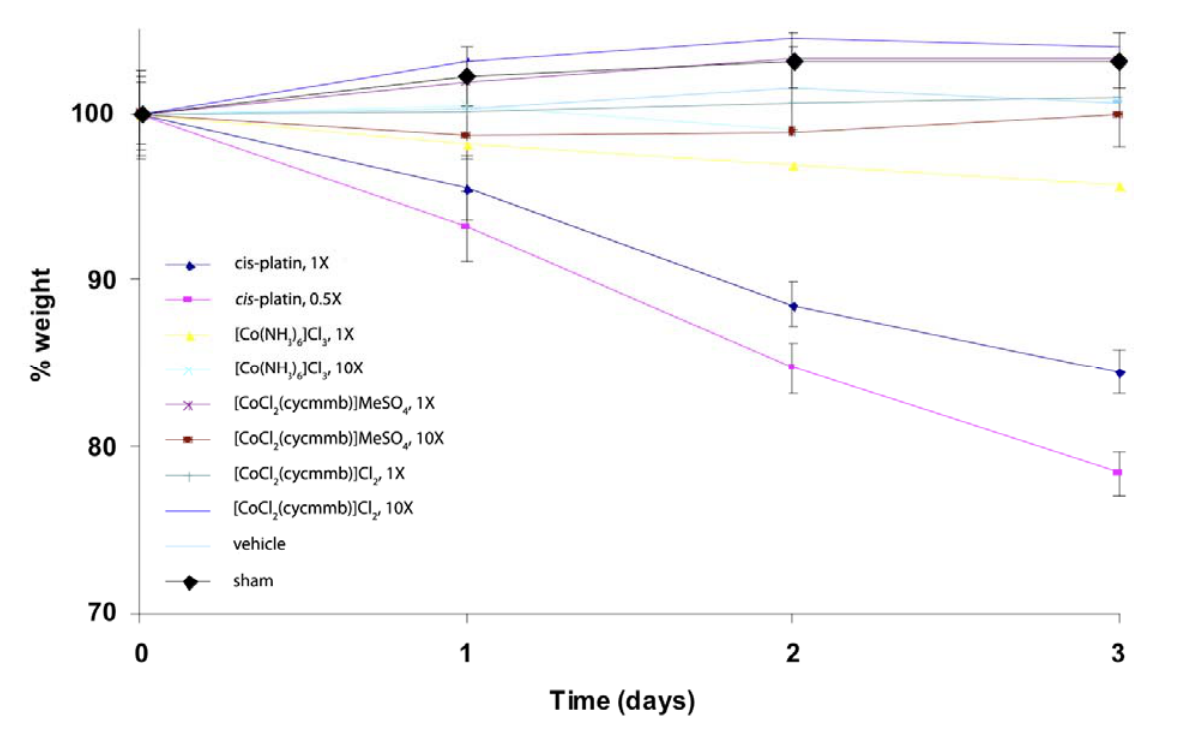
Figure 17. Weight loss of C57BL/6J mice exposed to platinum(II) and cobalt(III) complexes. 1X is equivalent to approx. 1 mM [Co(NH Cycmmb = methyl